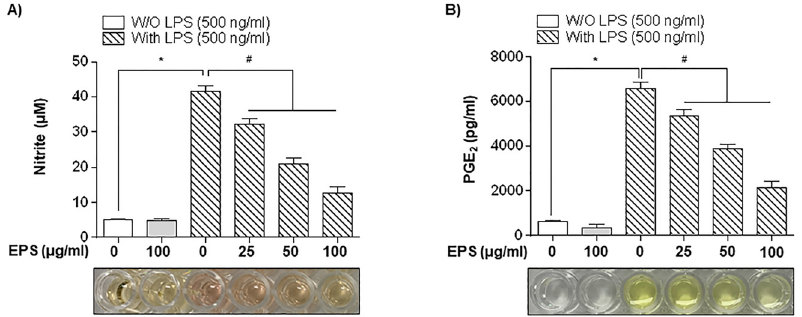
Figure 3: Down regulation of nitric oxide (NO) and prostaglandin E 2 (PGE 2 ) production by EPS in lipopolysaccharide (LPS)-stimulated RAW 264.7 cells.